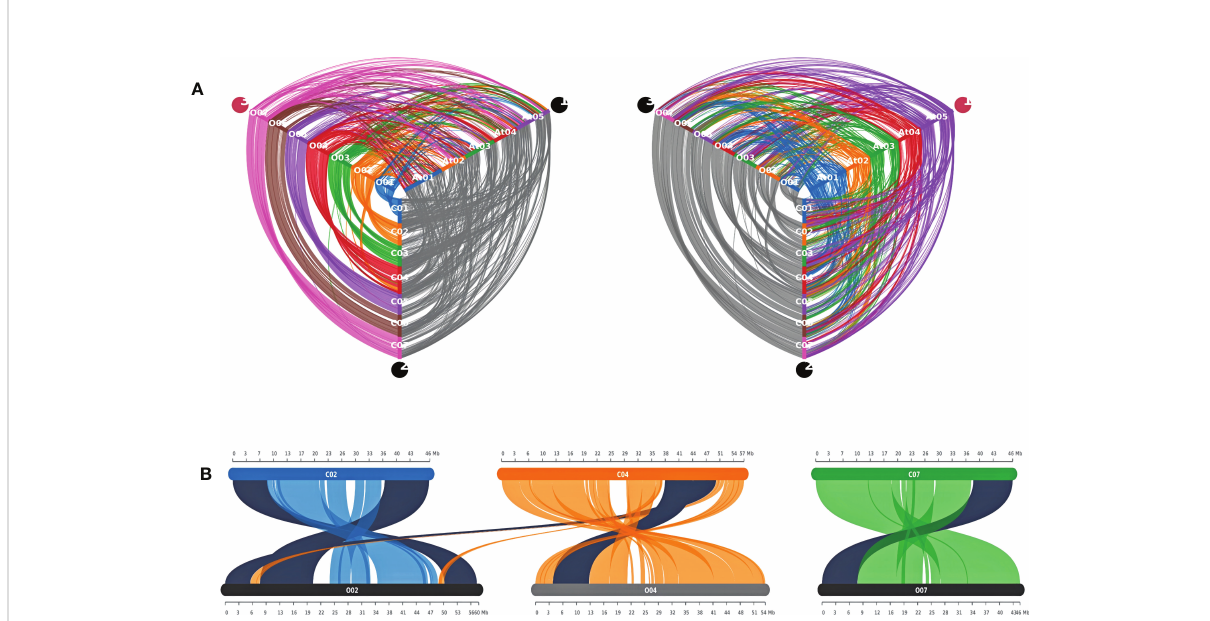
FIGURE 8 Synteny analysis between C capsularis , C olitorius , and A thaliana genomes. (A) Hive plots showing the syntenic conservation among the three genomes. (B) Syntenic CCoAOMT genes between the two jute genomes. Synteny pairs are highlighted in black.